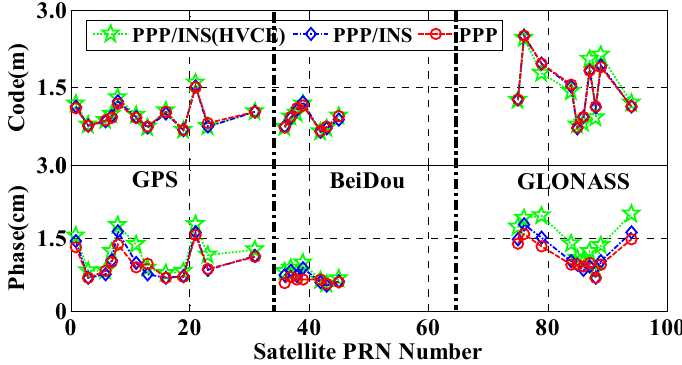
Figure13. RMS of attitude offsets from the PPP/INS tightly coupled integration mode without ( top ) and with the HVCE based adaptive scheme ( bottom ) using GPS, G + R, G + B, and G + R + B GNSS data: GPS (PRN < 35), BeiDou (35 < PRN < 70), and GLONASS (70 < PRN < 105).